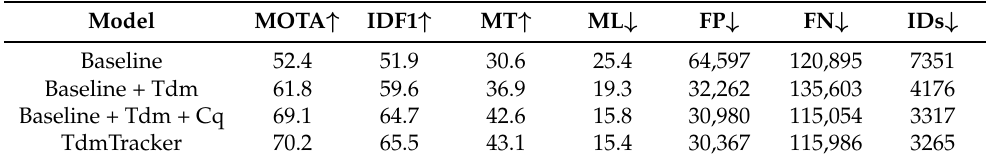
Table 2. Ablation study on MOT17 dataset. ↓ means the smaller the better; ↑ means the larger the